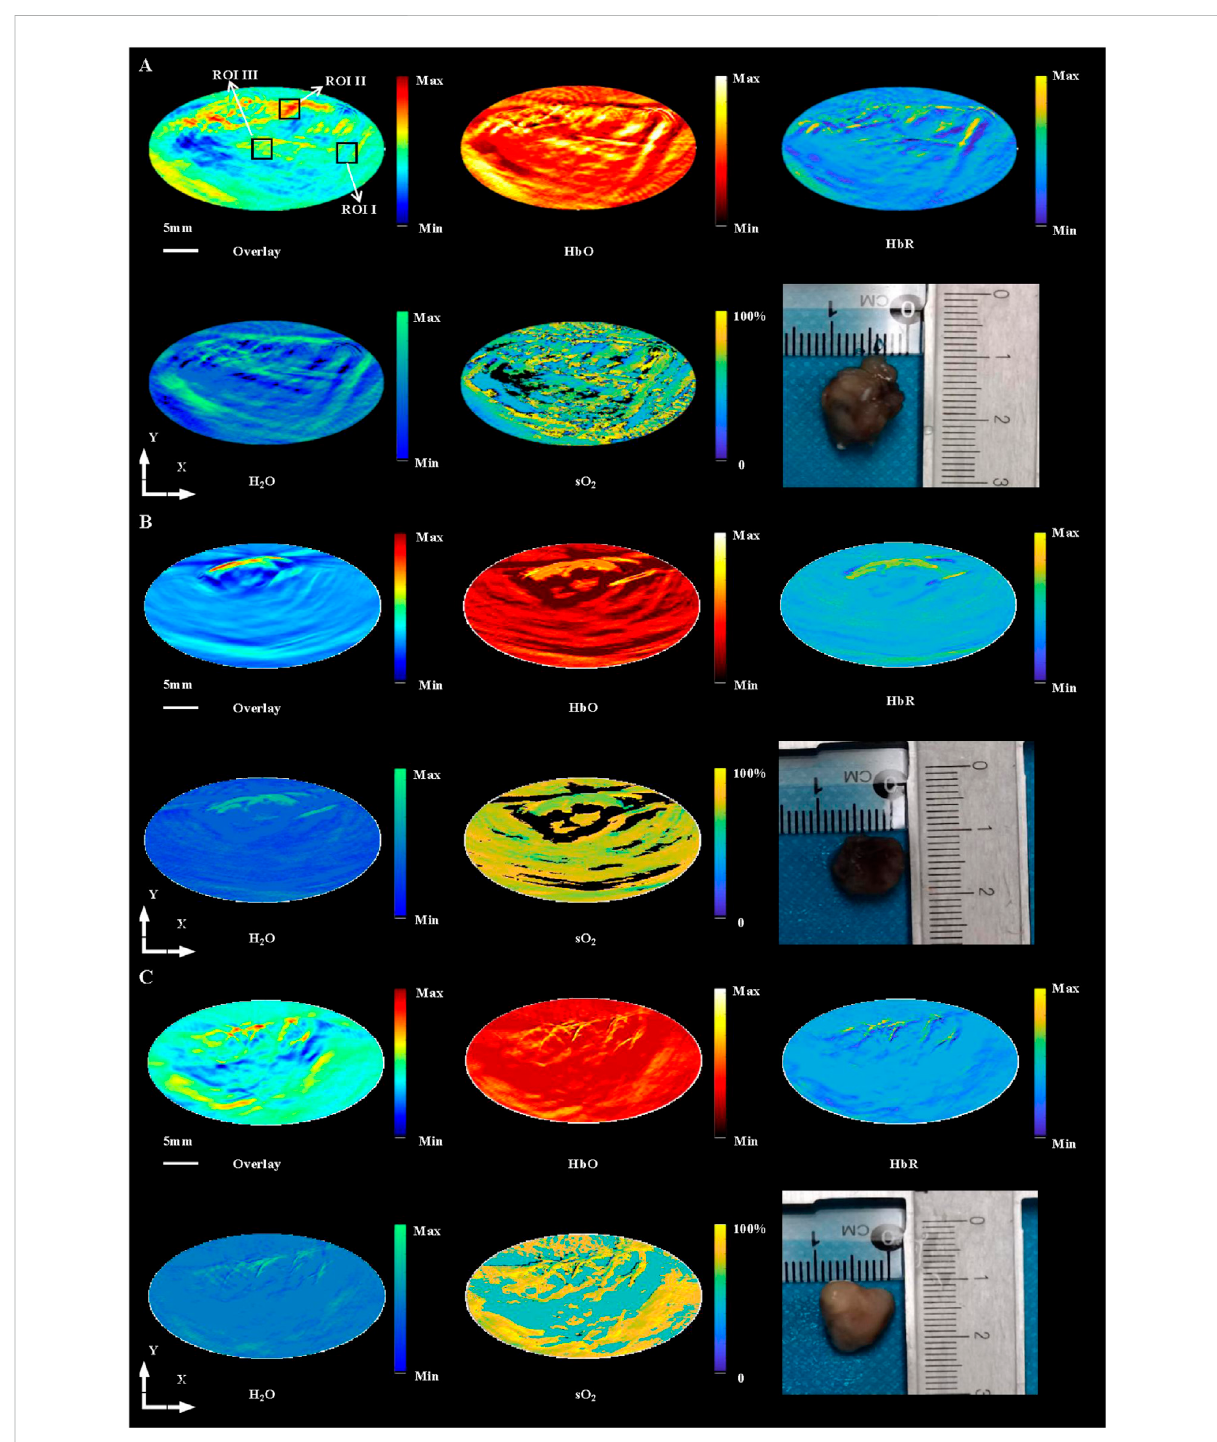
FIGURE 3 Invivo imagingof4T1breasttumorsatHbT(overlay),HbO,HbR,H 2 OandsO 2 distributionincontrolgroup (A) ,14×2 Gygroup (B) and3×8 Gy group (C) at25 daysafterradiotherapy,andhistologicalphotographofthreecollectedtumortissuesindifferentgroups.ROII,ROIII,andROIIIIin(A) indicates the baseline, peritumor and intratumor respectively. Scale bar = 5 mm for the